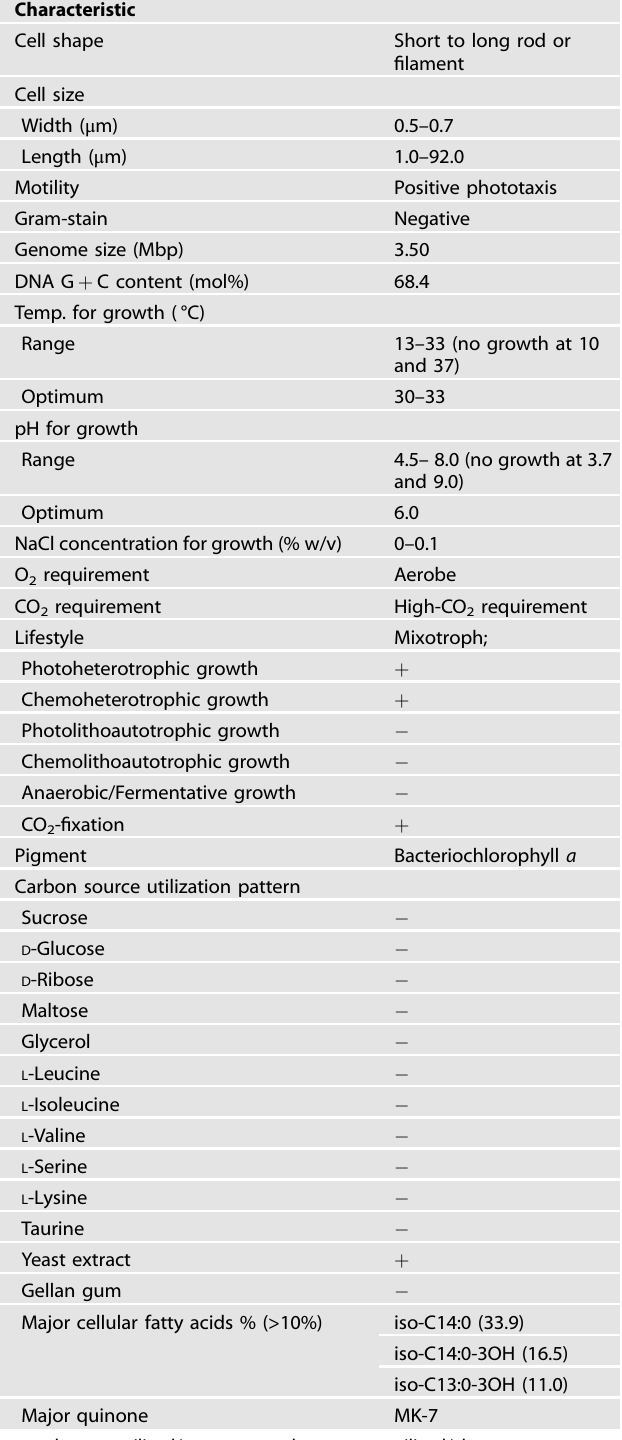
Table 1. Summary of the phenotypic traits of strain